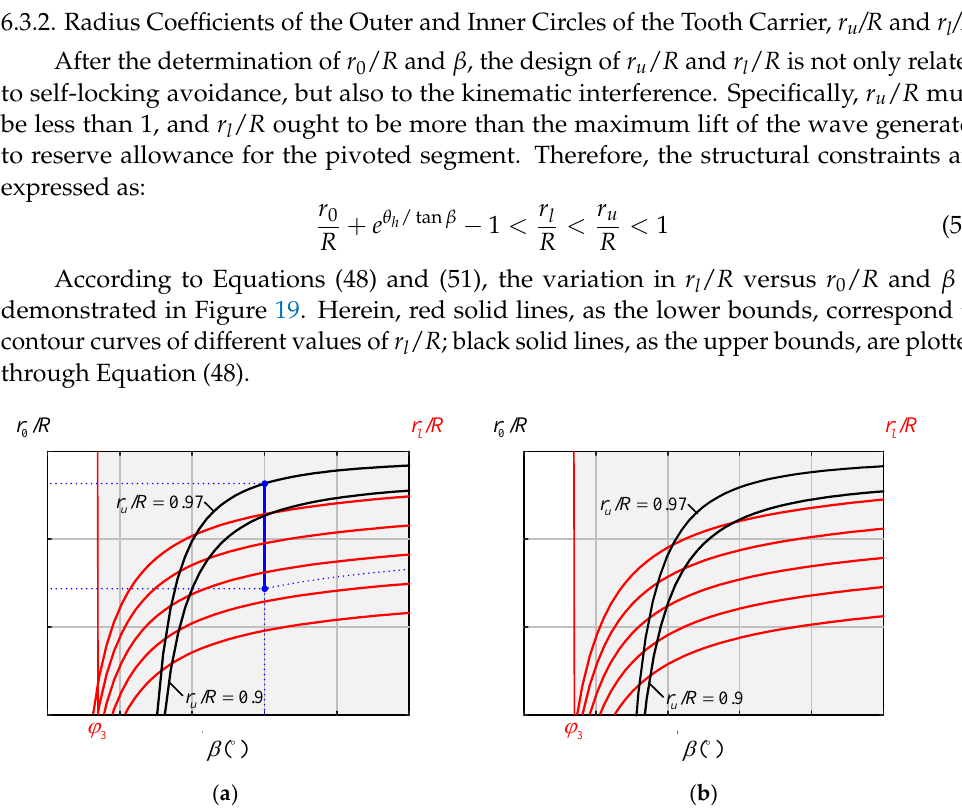
Figure 19. Ranges of r u / R and r l / R corresponding to different r 0 / R and β . ( a ) I = 24; ( b ) I = 24.